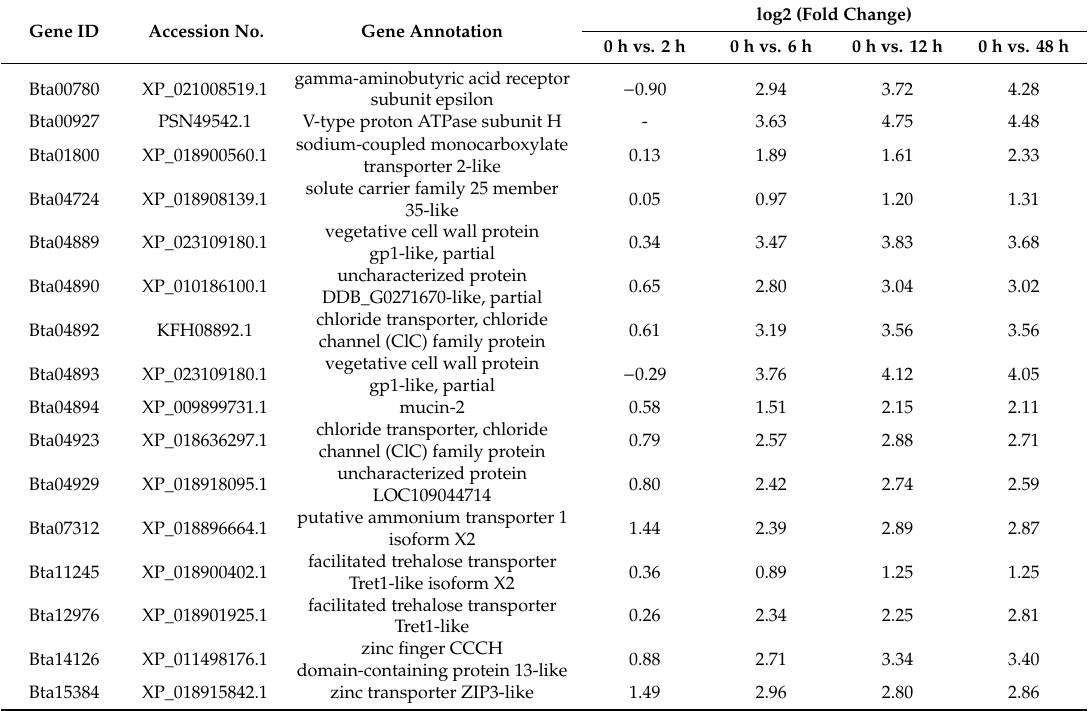
sodium-coupled monocarboxylate XP_018900560.1 transporter 2-like